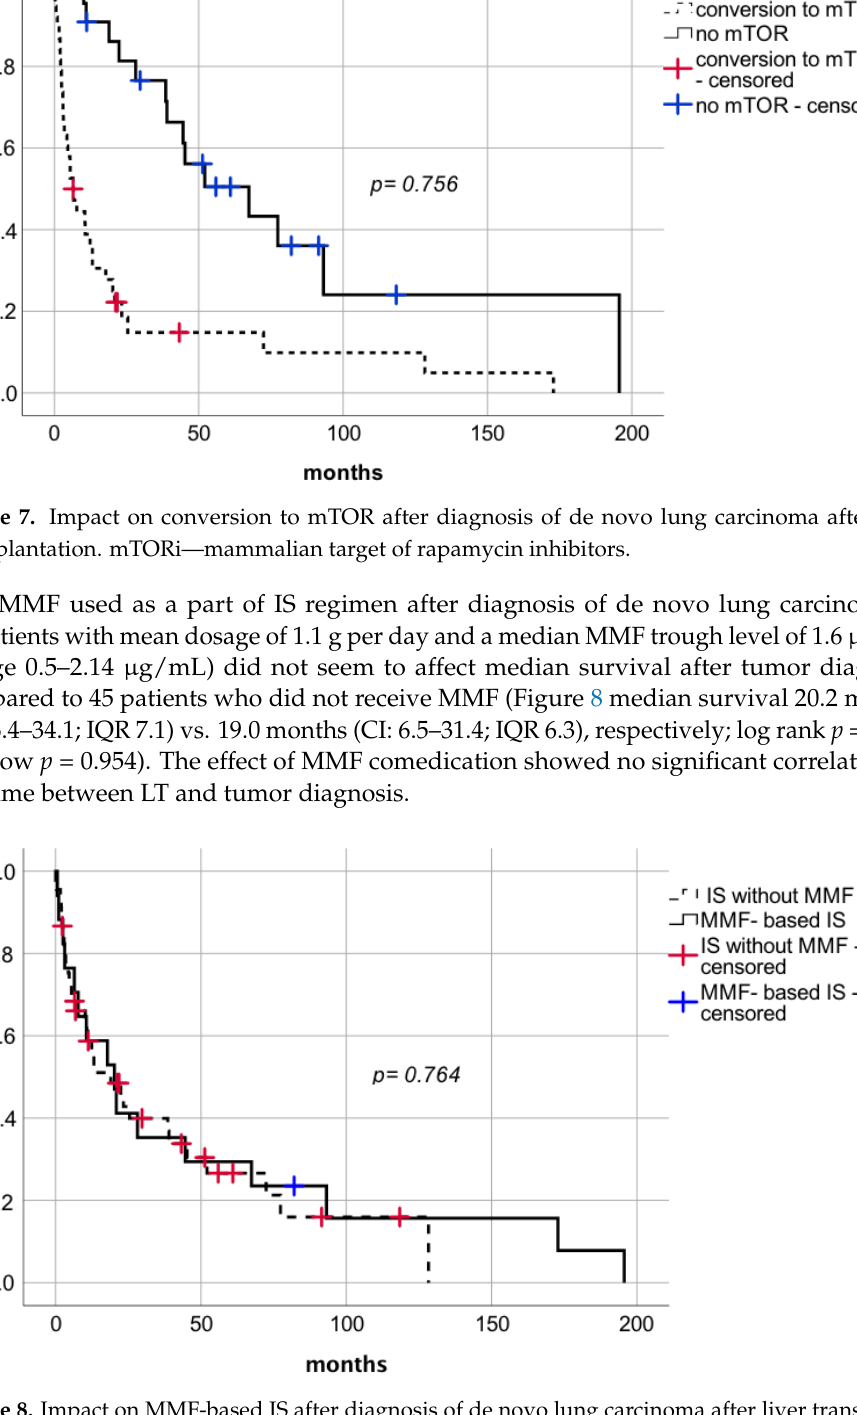
10 of 16 Figure 6. Impact on modification of immunosuppressive therapy in patients with palliative treat-